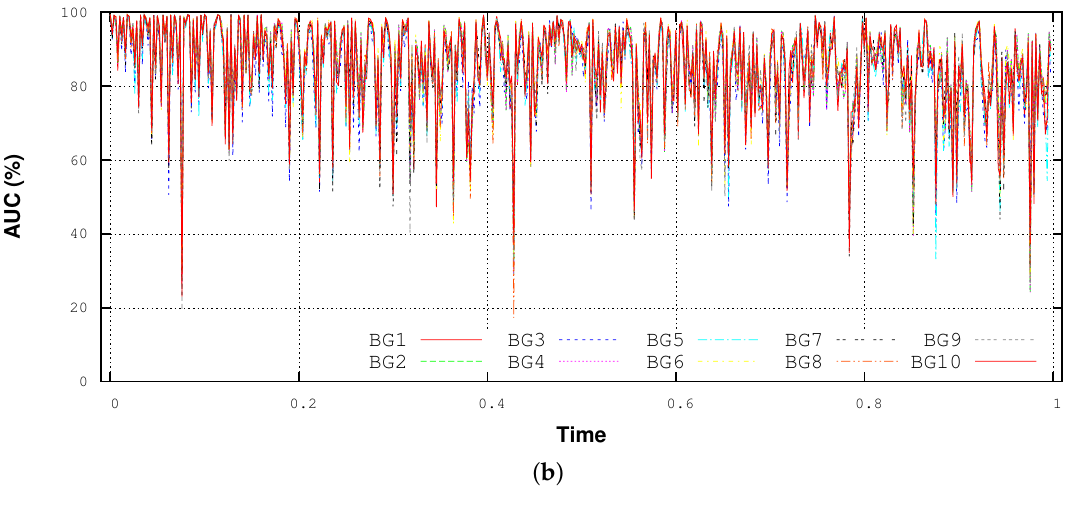
Figure 9. AUCs achieved by GMM and HMM backgrounds in the starting point analysis. ( a ) GMM; ( b )